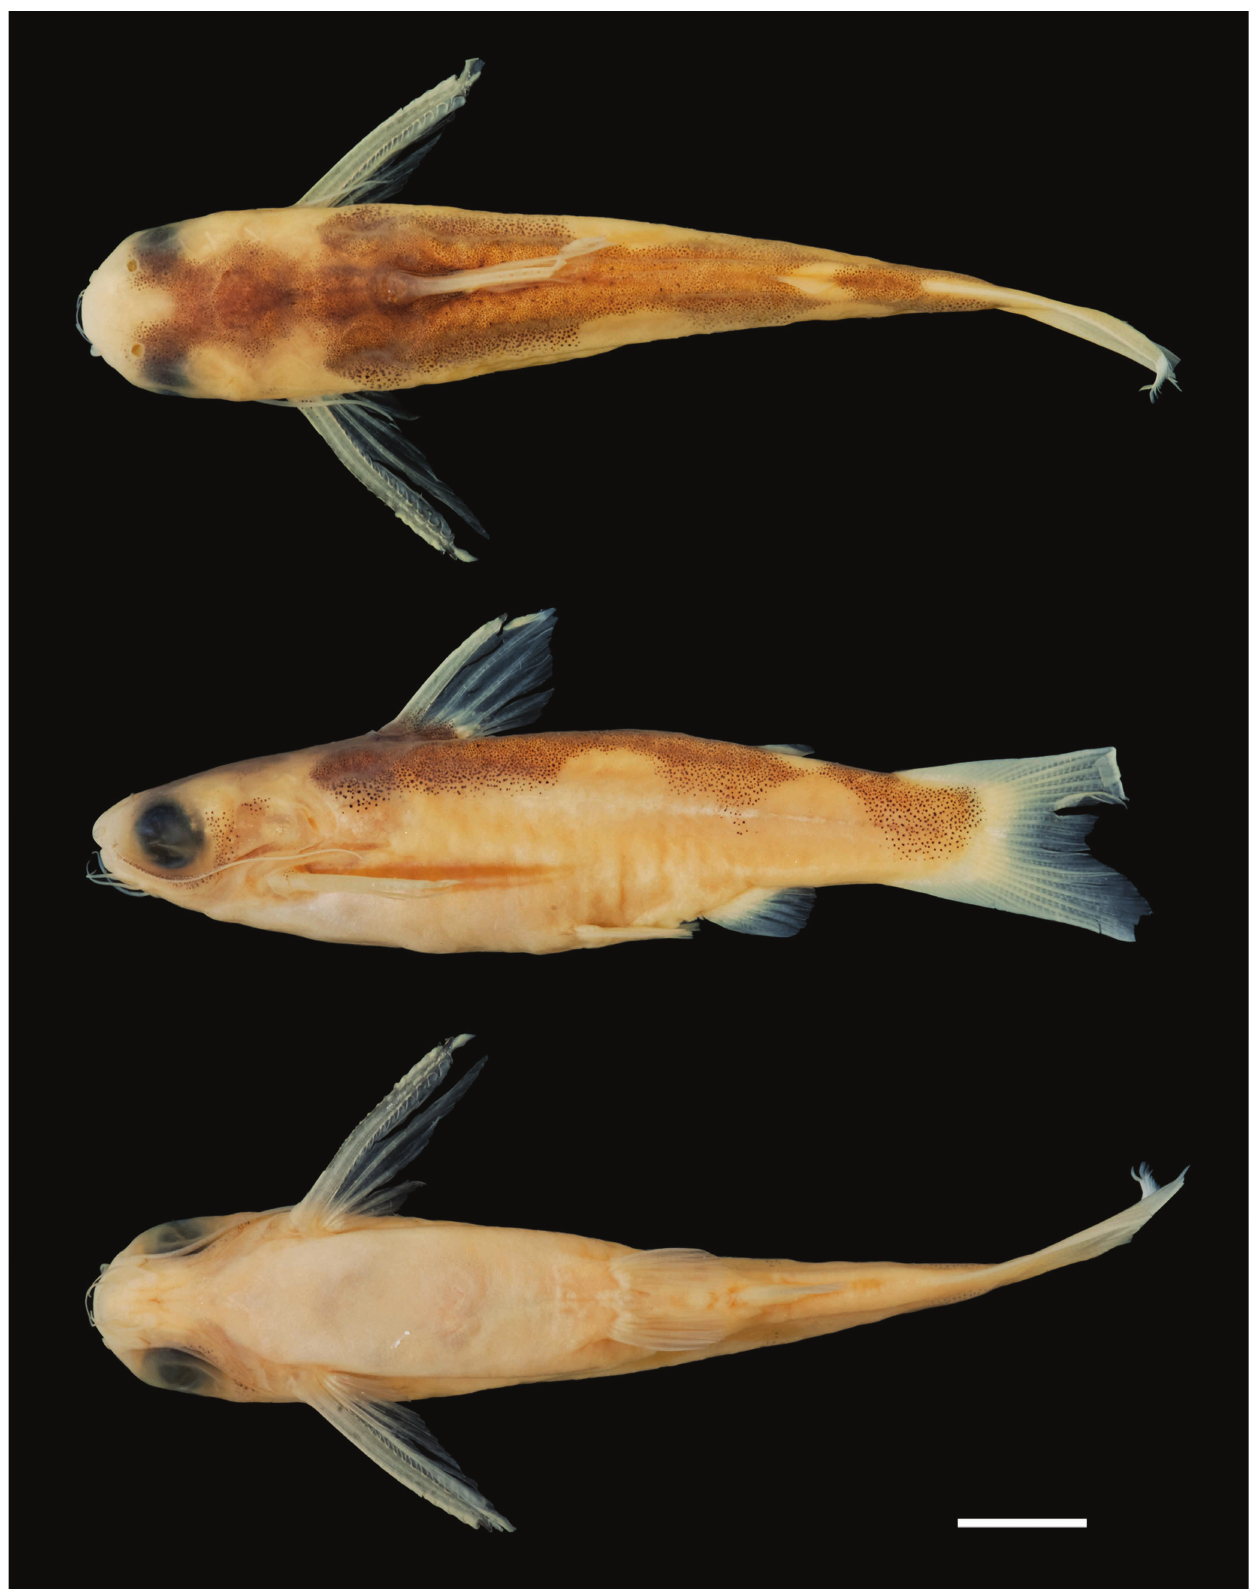
Fig. 1. Tatia melanoleuca , new species, MZUSP 114670, holotype, female, 32.4 mm SL, Brazil, along border between Pará and Mato Grosso states, Jacareacanga, rio Teles Pires, close to Sete Quedas, upper rio Tapajós basin; dorsal, lateral and ventral views. Scale bar = 0.5